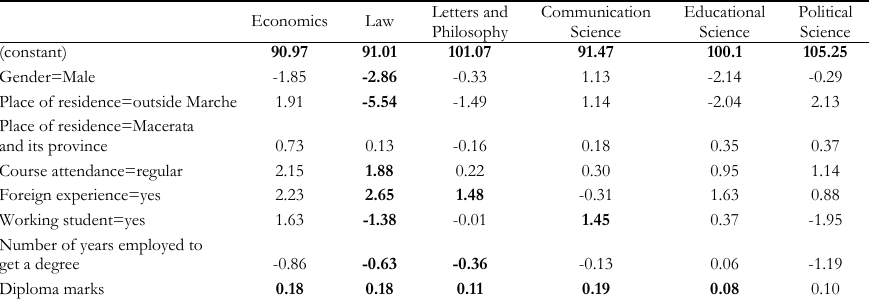
LS estimations by Faculty (in bold significant coefficients at α